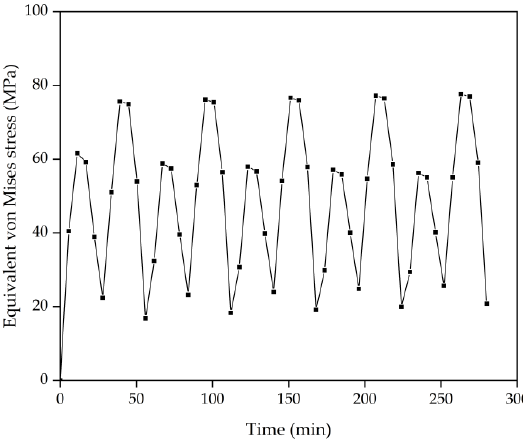
Figure 12. Change in maximum stress in load cycle. The maximum stress of chip-1 to chip-5 is 75.63, 59.60, 49.44, 46.94 and 26.60 MPa